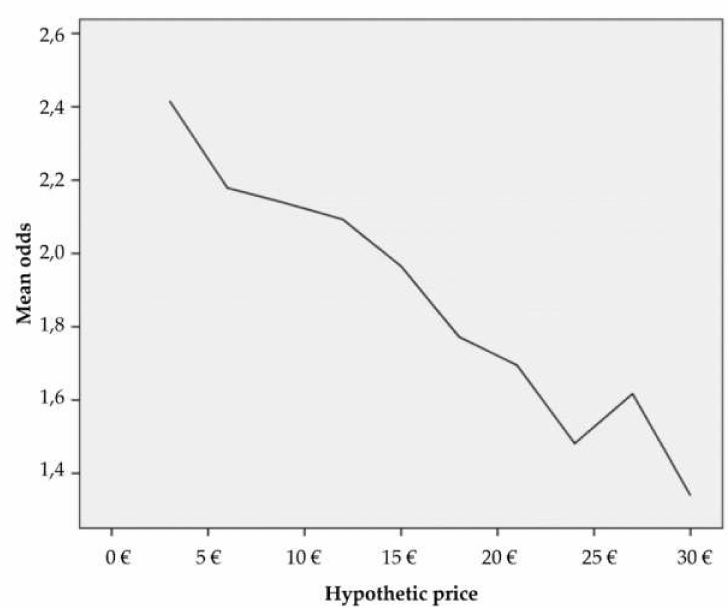
Figure 2. The odds’ graph with regard to the price. Source: own processing based on obtained data.